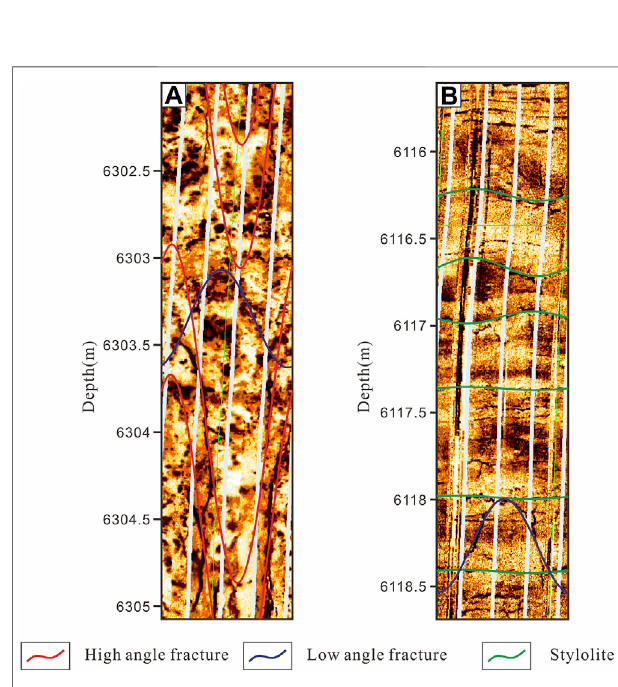
FIGURE 6 | Imaging logging of Yb27. (A) High-angle fractures of the Changxing Formation; (B) Stylolites of the Feixianguan Formation.